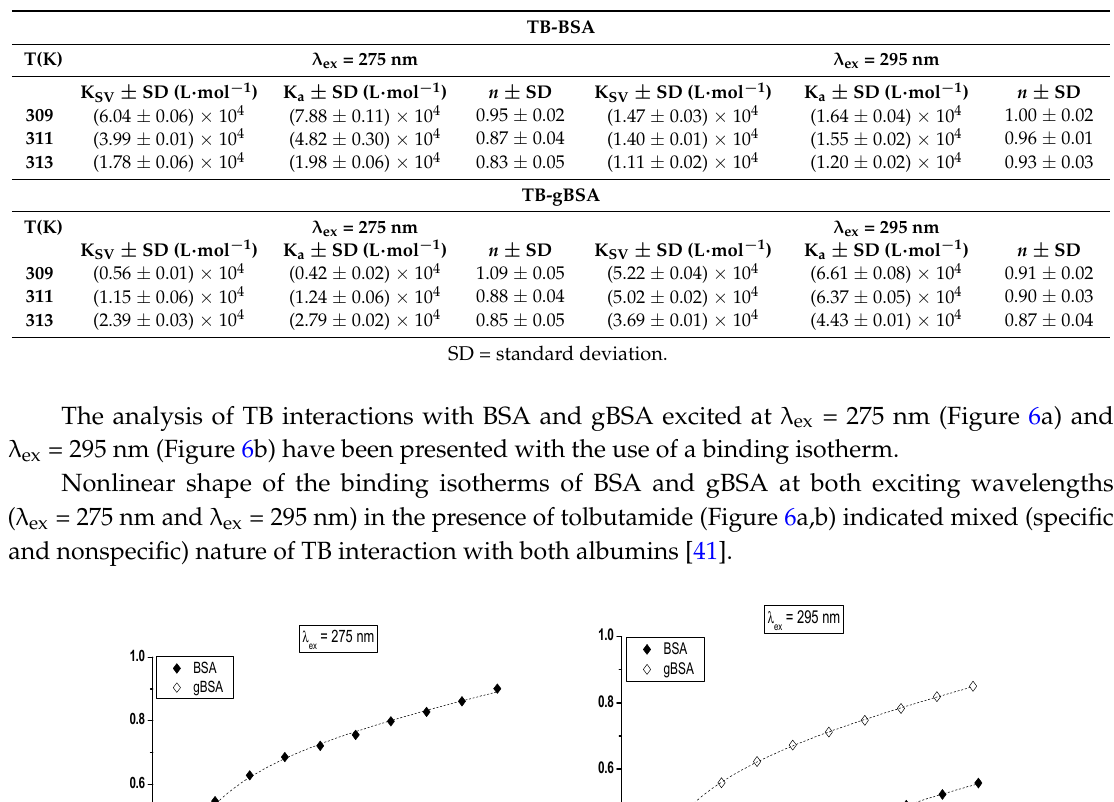
Table 3. The Stern-Volmer constant of protein fluorescence K SV , the association constant K a for the ligand-albumin complex and number of binding sites n determined for TB-BSA and TB-gBSA system; λ ex = 275 nm and λ ex = 295 nm.